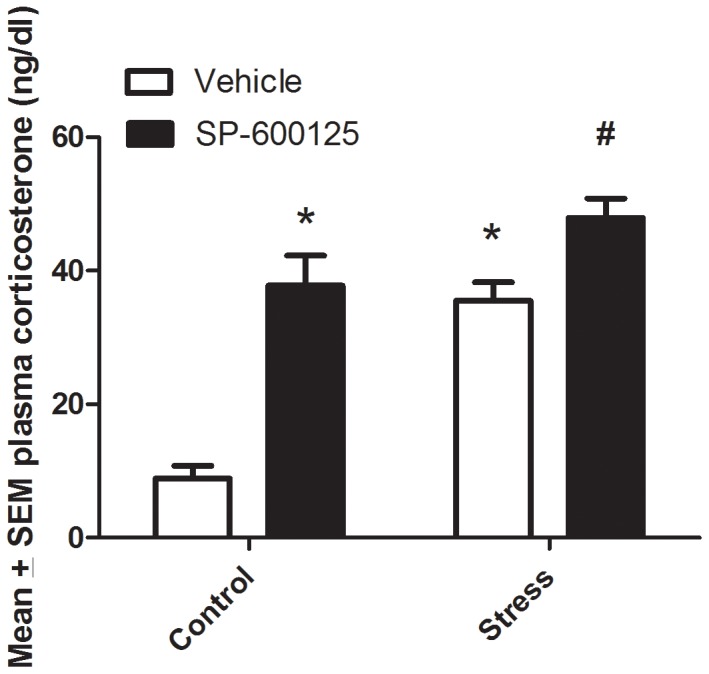
The effect of the JNK antagonist, SP600125, on corticosterone levels varied as a function of stressor treatment.The JNK antagonist and stressor individually increased corticosterone levels. However, the corticosterone rise was most pronounced in mice that received both the JNK antagonist plus the stressor. *p<0.05 relative vehicle control group; ρ p<0.05 relative to vehicle stress group. Error bars represent standard error of the mean (SEM).